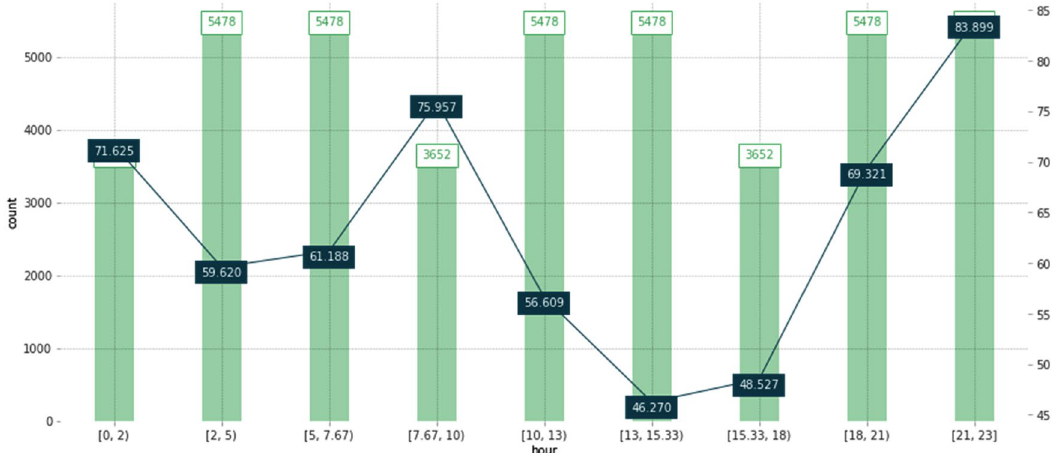
Figure 6. Target plot for the hour feature using the PDP.